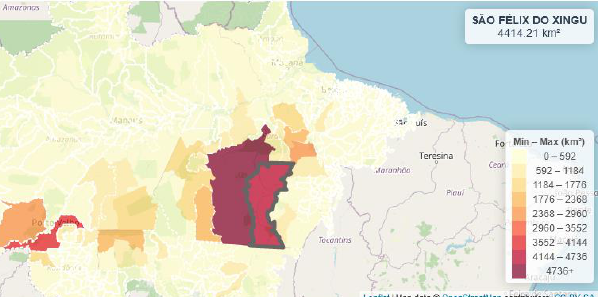
Figure 1 – Output map derived from TerraBrasilis platform showing the top ten municipalities in the BLA with the highest rates of deforestation according to PRODES 2019-2020 data.